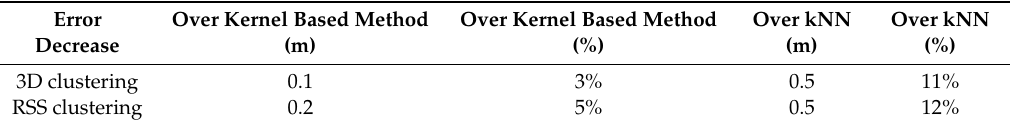
Table 5. The mean error decreasing numbers using compressive sensing over kNN and kernel based methods in building 1.